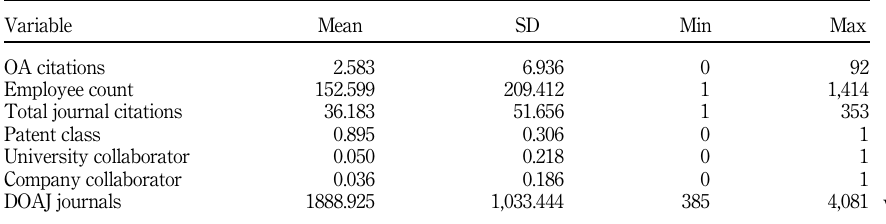
Table 2. Basic statistics for